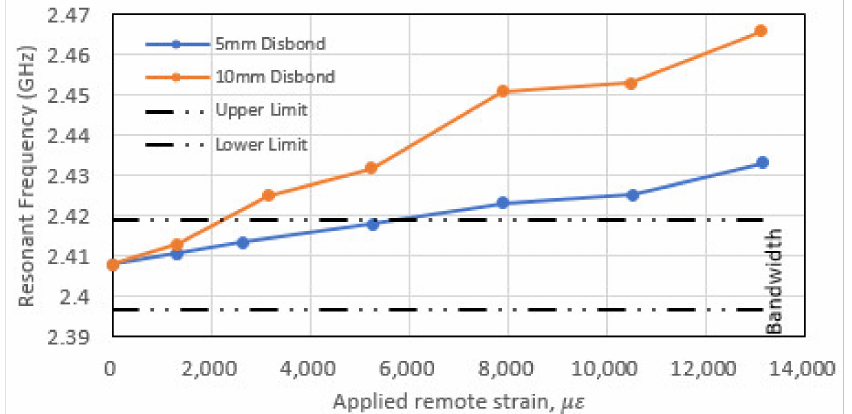
Figure 18. Resonance response of CLAS with disbond present (5 mm or 10 mm) with respect to mechanical